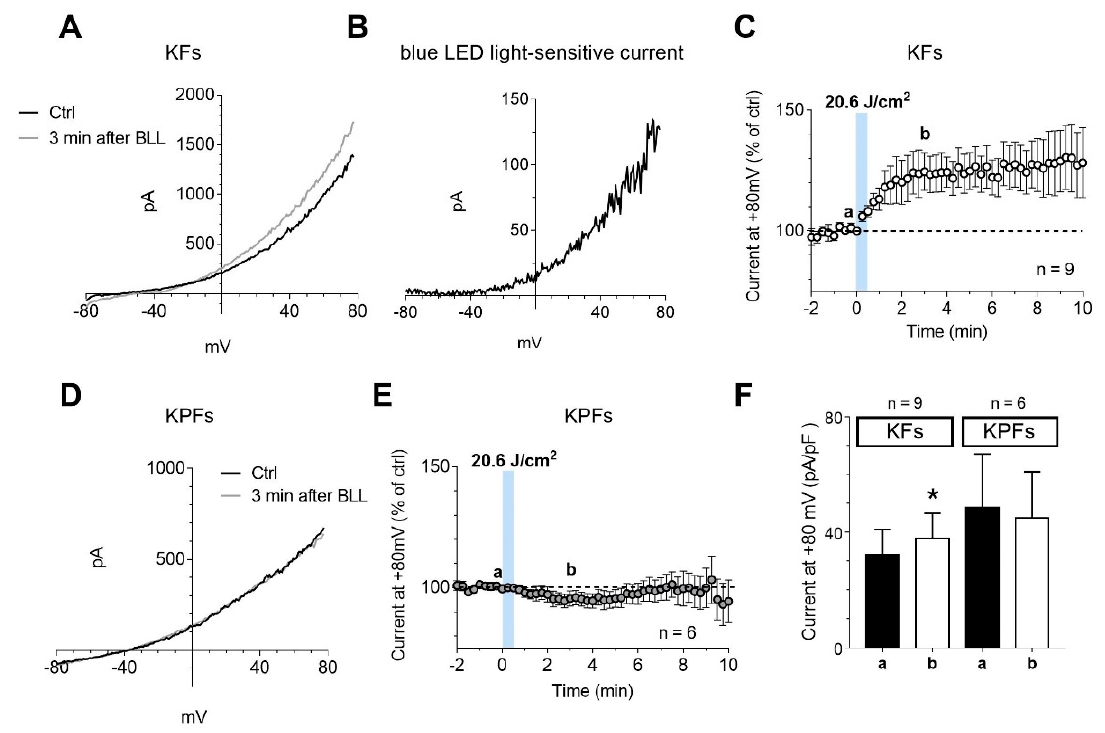
Figure 7. The application of blue LED light increases outward currents only in cultured keloid fibroblasts. ( A , D ) Original whole-cell patch clamp current traces evoked by a voltage ramp protocol (from − 80 to + 80 mV, 800 ms) before (Ctrl, black traces) or 3 min after the application of 20.6 J / cm 2 of blue LED light (BLL, grey traces) in a typical keloid fibroblast (KF, A) or perilesional keloid fibroblast (KPF, D). ( B ) Net blue LED light-sensitive current obtained by subtraction of the control ramp from the ramp recorded 3 min after irradiation in the same cell shown in A . ( C , E ) Averaged time courses (mean ± SEM) of ramp-evoked currents at + 80 mV in KFs (n = 9) ( D ) or KPFs (n = 6) ( E ) before, during and after the application of 20.6 J / cm 2 fluence of blue LED light (a,b). Each graph represents the corresponding points chosen for the analysis shown in ( F ). ( F ) Pooled data (mean ± SEM) of ramp current amplitude at + 80 mV, recorded before (a) or after 3 min (b) of blue LED light application in KFs (n = 9) or KPFs (n = 6). Statistical analysis: * p < 0.05, paired Student’s t